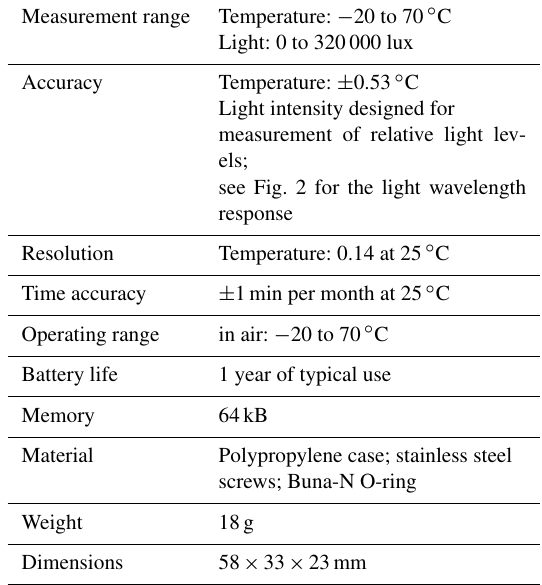
Table 1. Characteristics of the HOBO ® Pendant Temperature/Light Data Logger as per the